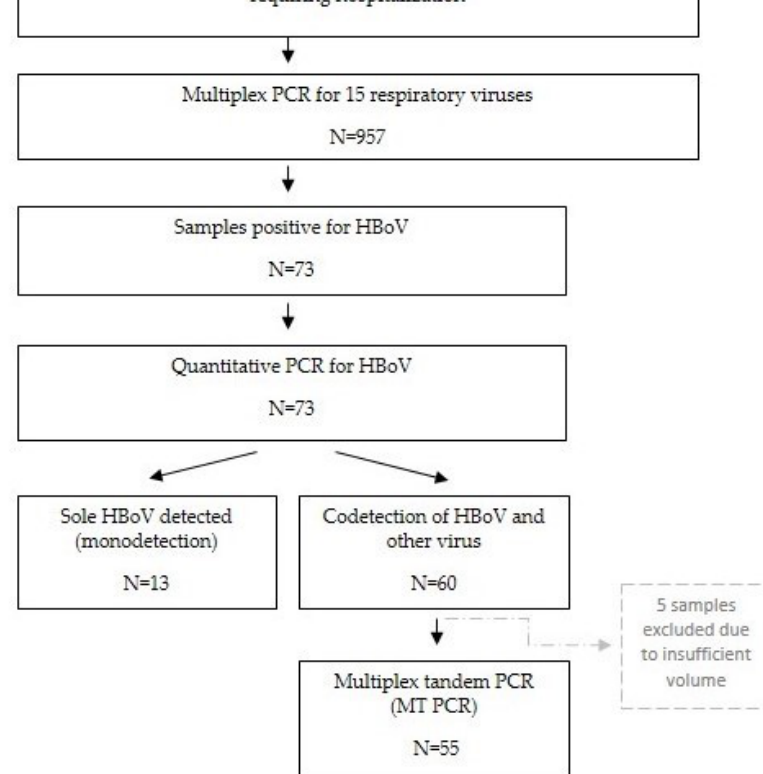
Figure 1. Conceptual framework of the